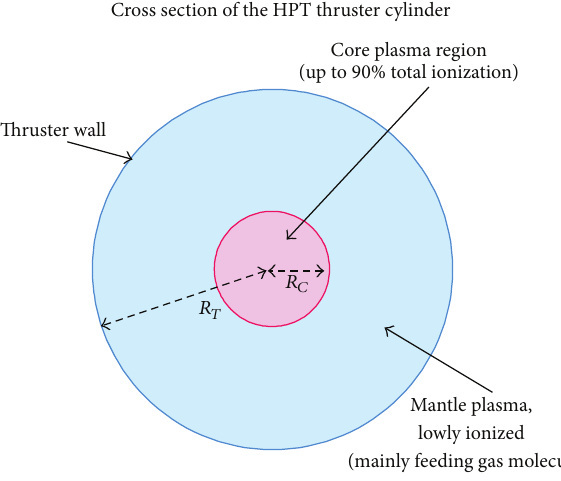
Figure 1: Cross section of the HPT thruster cylinder.